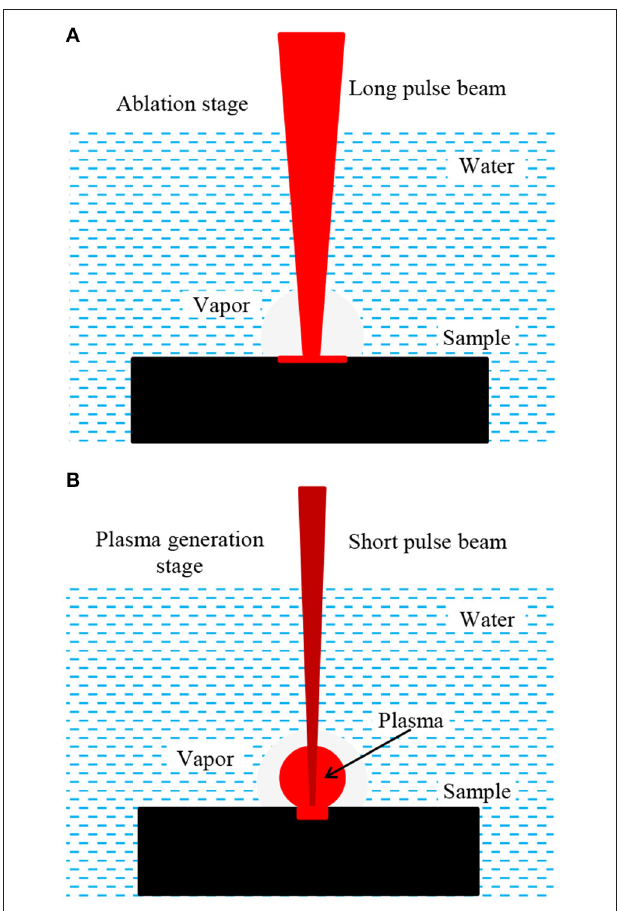
FIGURE 7 | Principle model of underwater measurement using collinear LS-DP-LIBS. (A) Ablation stage of long pulse and (B) plasma generation stage of short pulse.